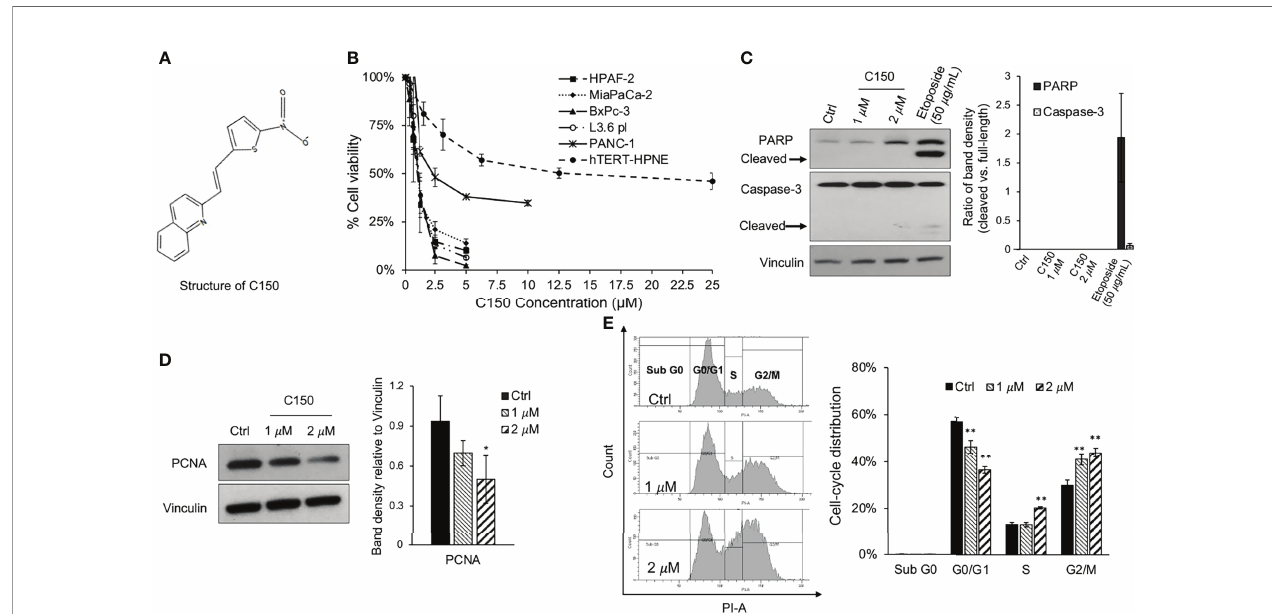
FIGURE 1 | C150 inhibits pancreatic cancer cell proliferation. (A) Structure of C150. (B) Cell viability upon C150 treatment. The human pancreatic cancer cell lines HPAF-2, MIA PaCa-2, BxPC-3, L3.6pl and PANC-1, and the immortalized normal human pancreatic ductal epithelial cell hTERT-HPNE, were incubated with increasing concentrations of C150 for 48 h. Cell viability was analyzed by MTT assay and normalized to untreated controls. (C, D) Western blot analysis of (C) apoptosis markers and (D) PCNA. PANC-1 cells were treated with DMSO (Ctrl) or C150 (1 and 2 m M) or etoposide (50 m g/ml) for 48 h. Vinculin was blotted as the loading control. (C) Bar graph shows the ratio of cleaved PARP band density to full PARP band density and the ratio of cleaved caspase-3 to full Caspase-3 band density. (D) Bar graph shows the PCNA band density relative to vinculin. (E) Cell cycle analysis. PANC-1 cells were treated with DMSO (Ctrl) or C150 (1 and 2 µM) for 48 h. Cells were then collected, fi xed in 70% ethanol, stained with PI and examined by fl ow cytometry. Left panel shows representative fi gures of cell cycle distribution. Bar graph shows the percentage distribution of each phase. Data represent mean ± SD of at least three independent experiments in all graphs. *P < 0.05, **P < 0.01 (vs. Ctrl) by one-way ANOVA-Tukey ’ s test. C150, 2-[2-(5-nitro-2-thienyl)vinyl]quinoline; PCNA, proliferating cell nuclear antigen; Ctrl,